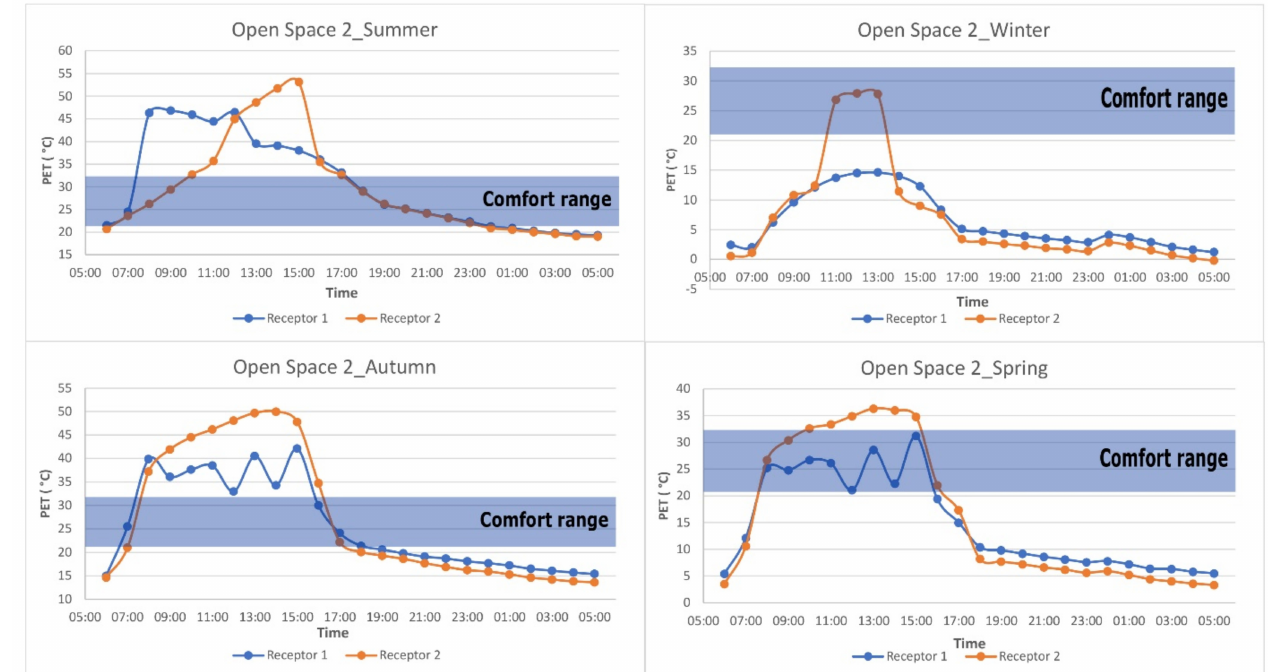
Figure 10. Open space 2 physiological equivalent temperature (PET) values throughout the